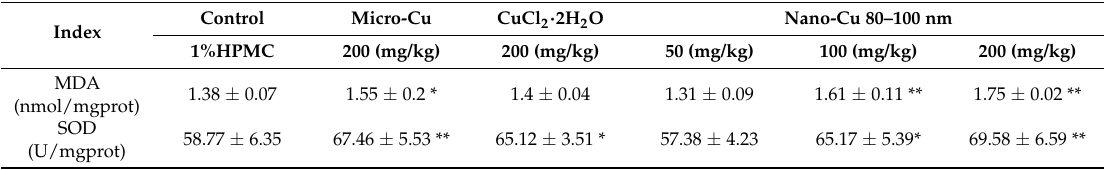
28 consecutive days. Table 3. Markers of oxidative stress in rats treated with copper sources by oral administration over